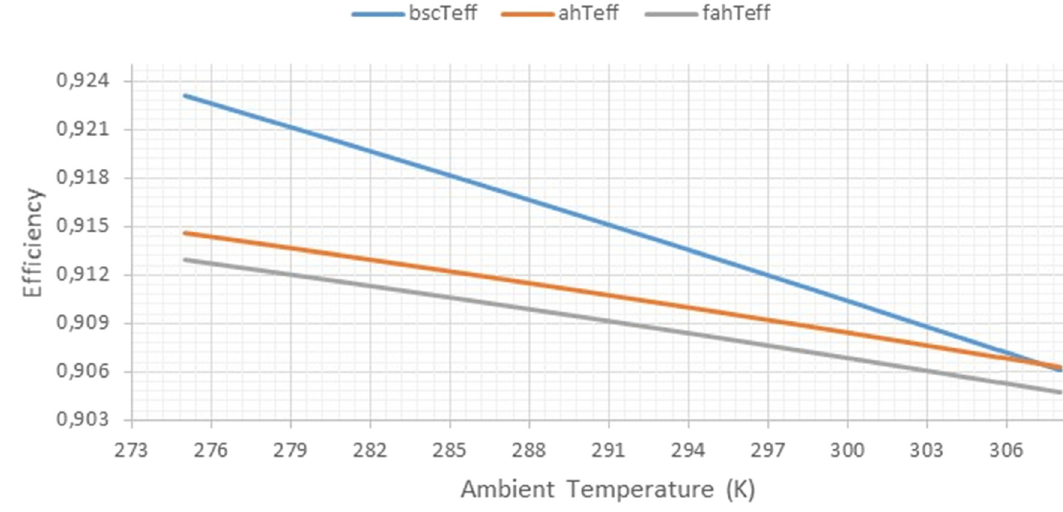
Figure 14: Variation of the turbine e ffi ciency with ambient temperature for bsc, ah and fah cogeneration